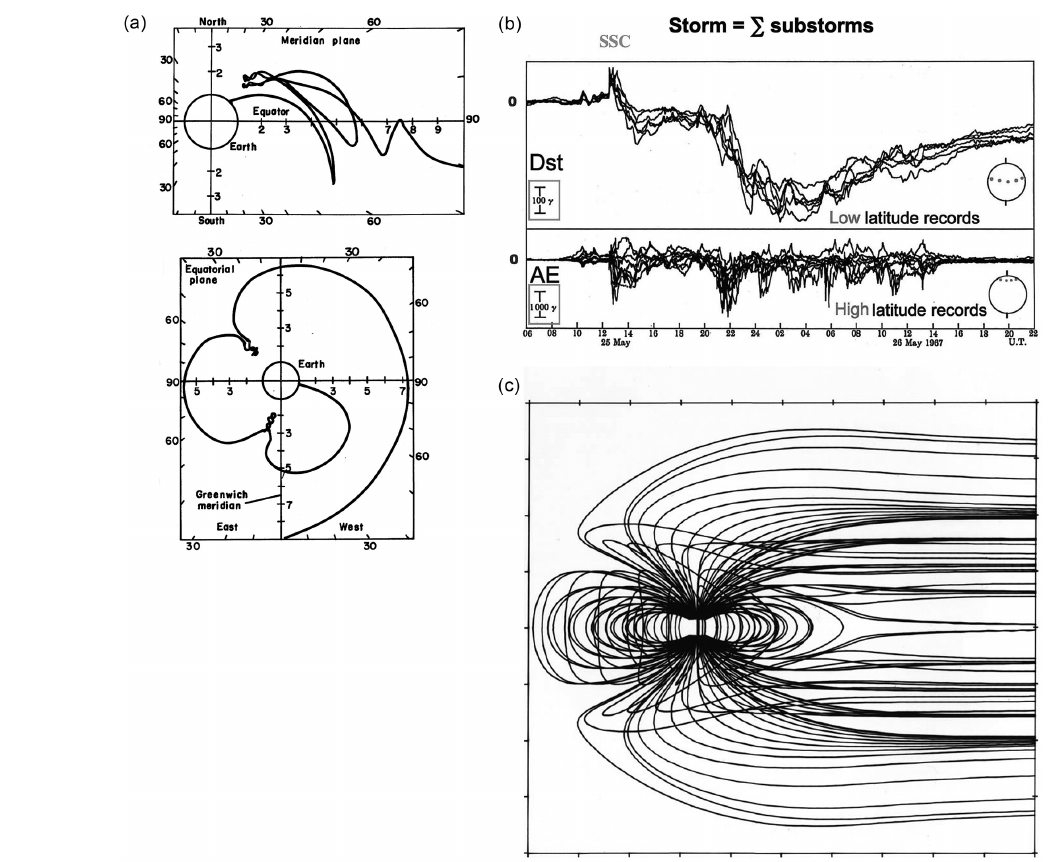
Figure 1. (a) An example of the trajectories of an electron in a dipole field (Stormer, 1955). (b) A typical example of a geomagnetic storm. The upper part is a collection of records (the horizontal component) at low-latitude observatories and the lower part at high-latitude observatories; note the difference of the scale in both. A step function-like change indicates the arrival of the shock wave, but Chapman considered that it signaled the arrival of solar plasma flow. (c) A non-magnetized plasma flow confines the earth and its magnetic field into a comet-shaped